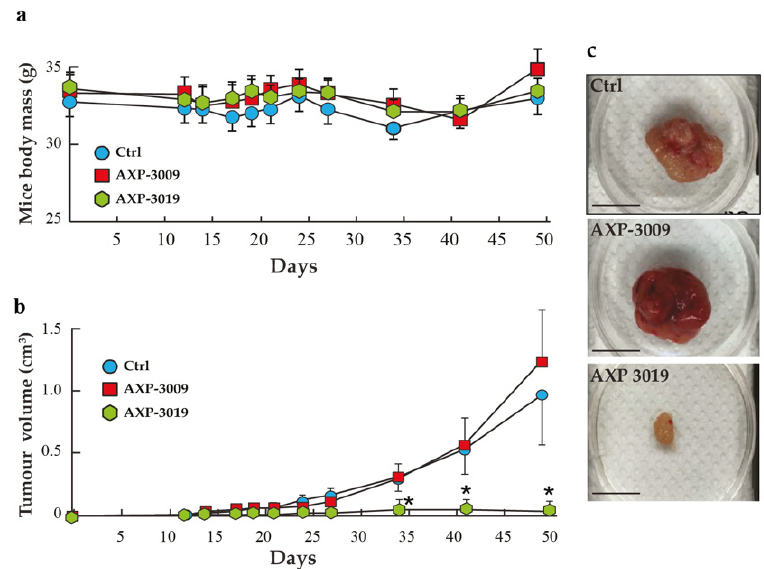
Figure 8. AXP-3019 strongly inhibits tumour-mass growth in mice xenografts. MIA PaCa-2 cells were subcutaneously injected into female nude mice. After 1 week, i.p. injections with PBS, AXP-3009, and AXP-3019 were administered biweekly for 30 days. Animals were sacrificed at the 50th day. ( a ) Mice body masses and ( b ) tumour volumes were measured every 2 days and values are the mean in each group. ( c ) Representative images of tumour masses grown in control, AXP-3009-, and AXP-3019-treated mice. Statistical analysis * p < 0.05. Scale bar, 1 cm.